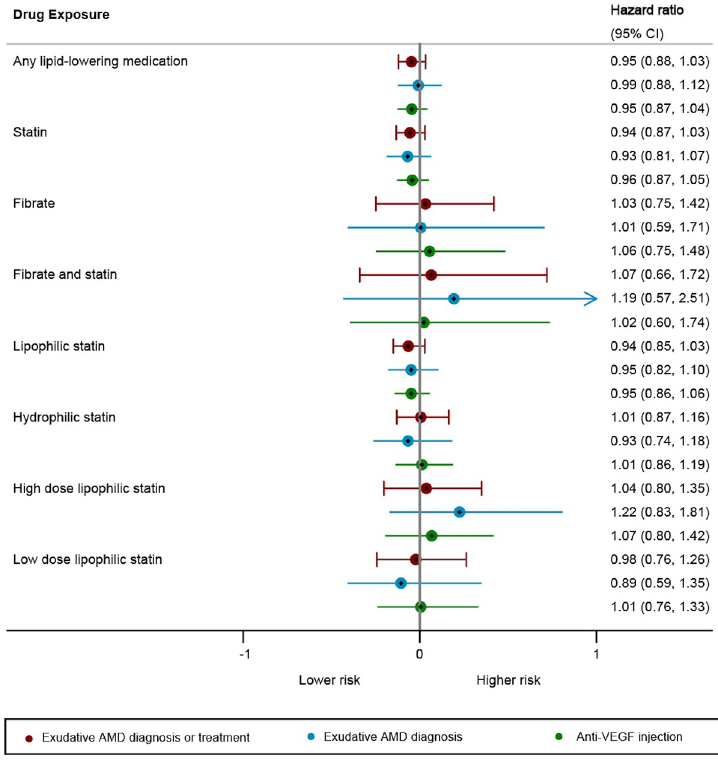
Fig 1. Forest plot demonstrating adjusted cox proportional hazards models of patients exposed to lipid-lowering medications and their progression to exudative AMD and/or need for treatment with anti-VEGF medication.